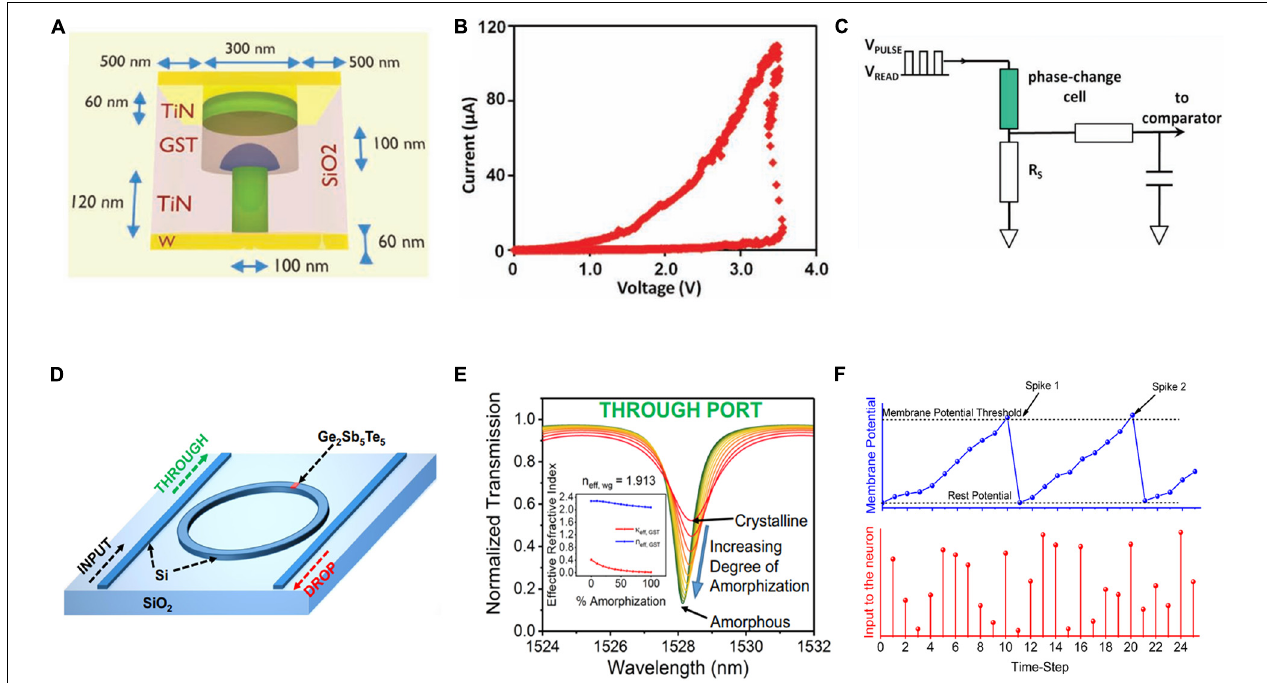
FIGURE 9 | (A) Schematic of the phase-change memory (PCM) mushroom-type cell. (B) Experimental I–V curve exhibiting a threshold switching voltage from amorphous to crystalline state. (C) Phase-change integrate-and-fire (IF) neuron circuit based on a single phase-change cell (Wright et al., 2012). (D) An optical neuron based on a GST cell. (E) Gradual change of transmission owing to different degrees of amorphization of GST ranging from 0% (crystalline) to 100% (amorphous). (F) Behavior of the proposed IF neuron in the spiking neural network (SNN) exhibiting the variation of the membrane potential under the action of incident pulses, thus resulting in the IF action (Chakraborty et al.,